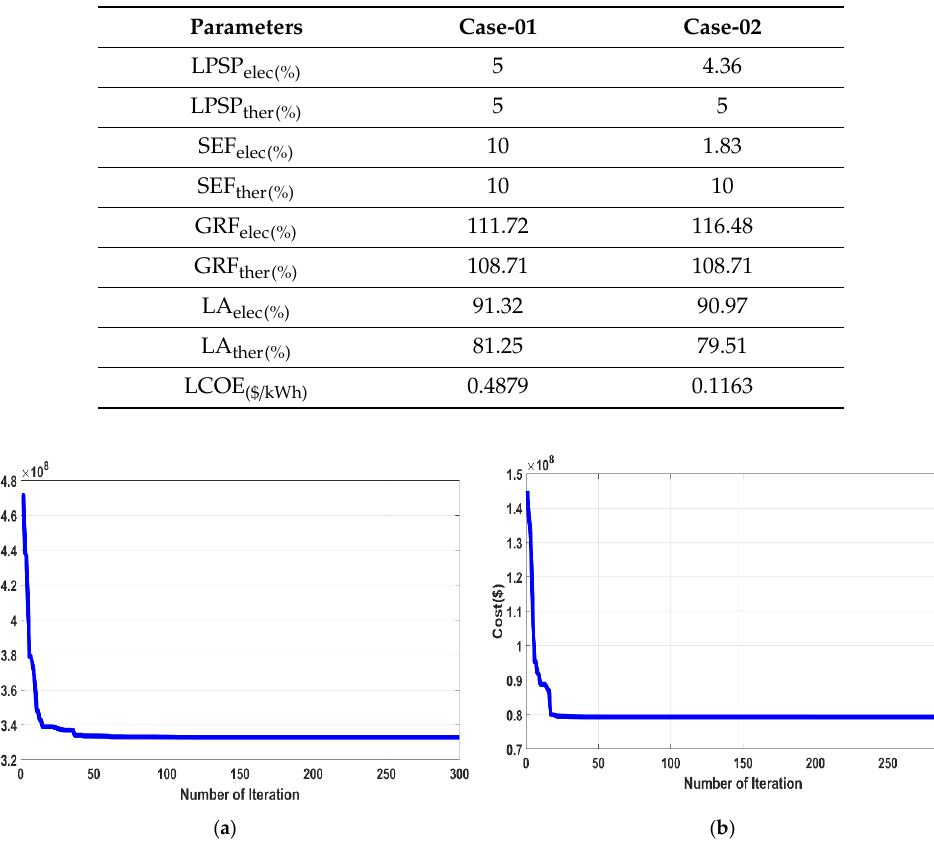
Figure 11. PSO convergence curve of ( a ) Case-01; ( b ) Case-02.